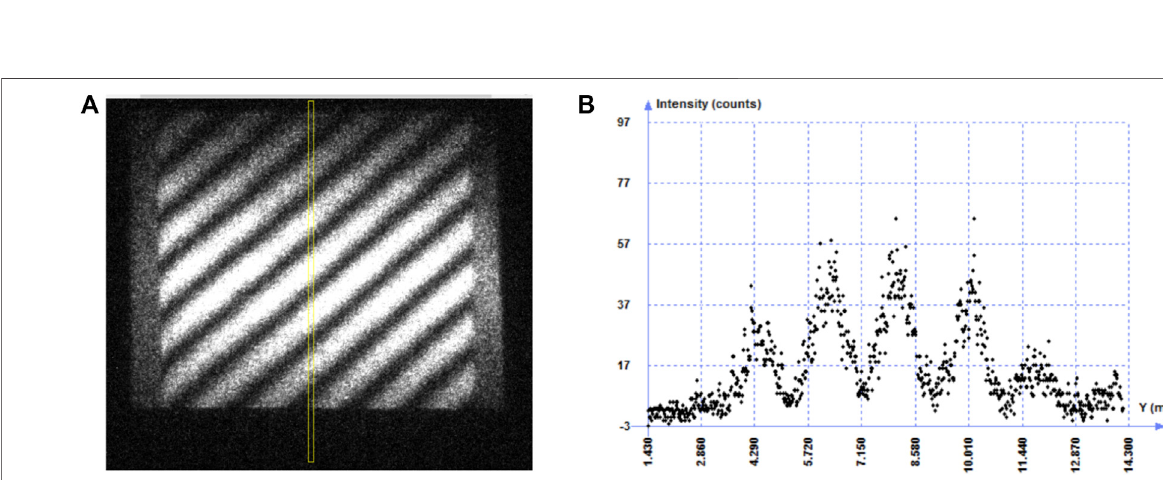
Frontiers in Physics |